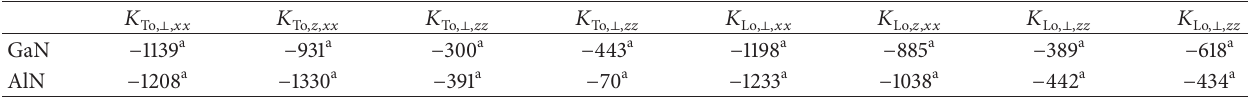
Table 3: Strain coefficients of the zone-center phonon modes 𝐾 ] 𝑗,𝜉,𝑥𝑥 and 𝐾 ] 𝑗,𝜉,𝑧𝑧 (in units of cm − 1 ).